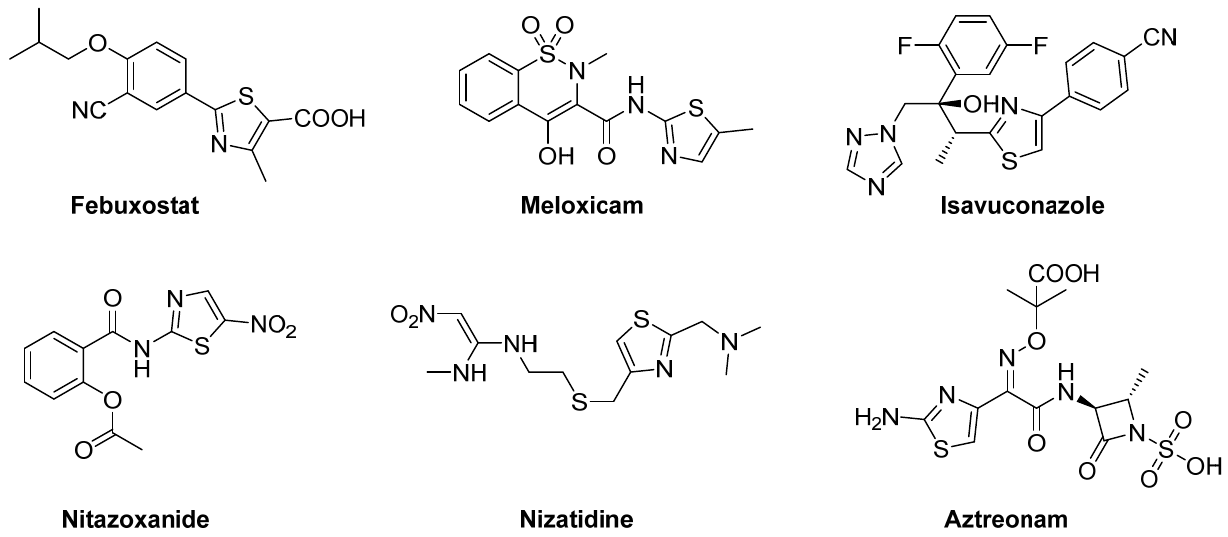
Figure 1. Selected structures of 1,3-thiazole-based FDA-approved drugs. Among 1,3-thiazole analogues, 2-(2-hydrazinyl)-1,3-thiazoles demonstrated a broad range of therapeutic applications, including antitumor, antiplasmodial, antiviral, and